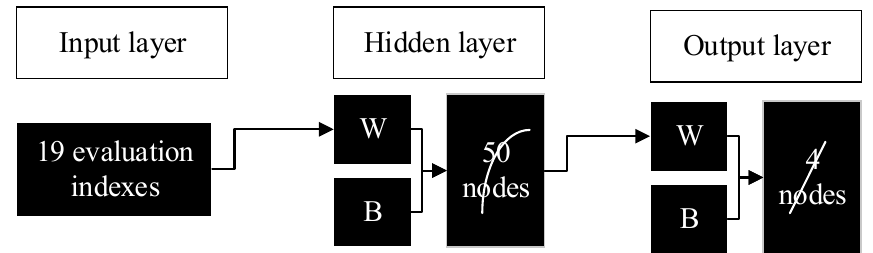
Figure 4. Urban land use smart growth evaluation model .